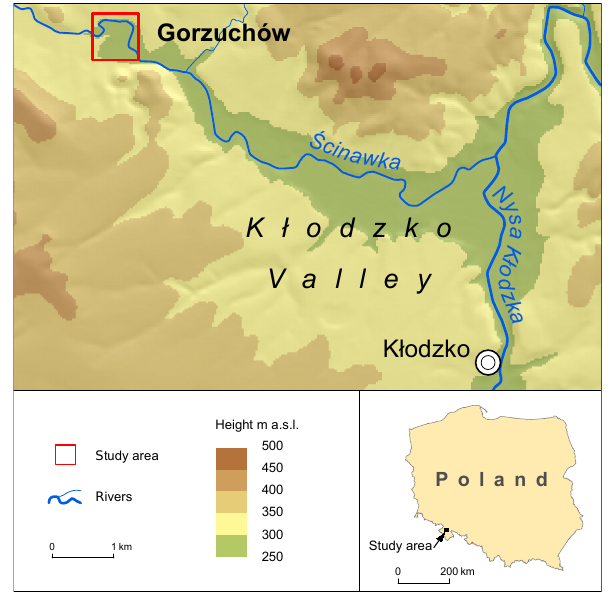
Figure 2. Map of study area.